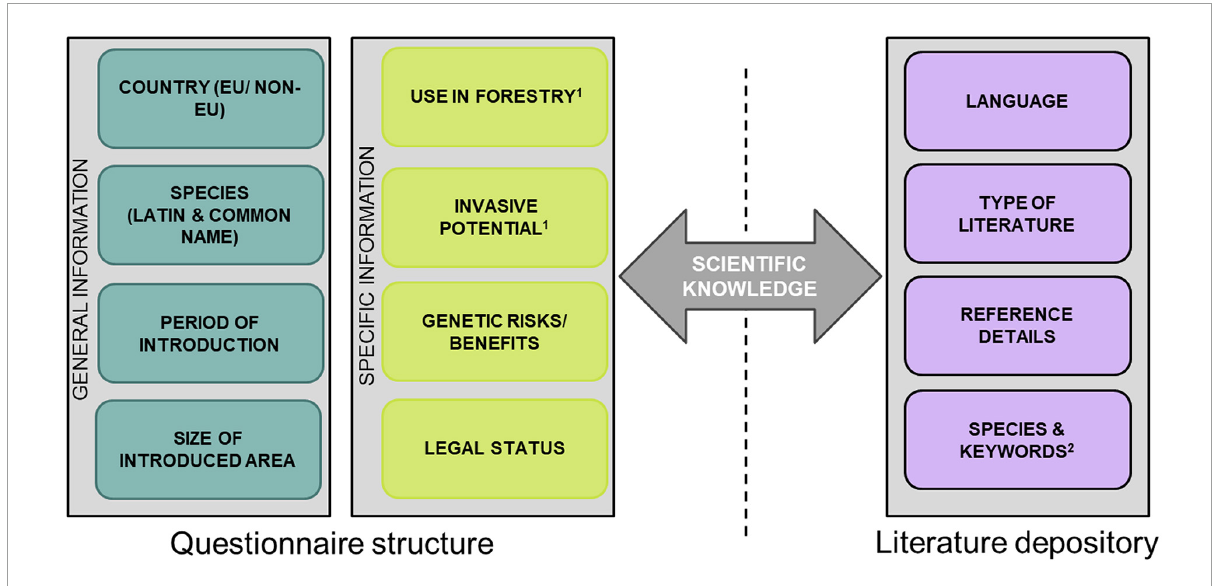
FIGURE1 Summary of the WG2-D6 questionnaire structure and literature depository.